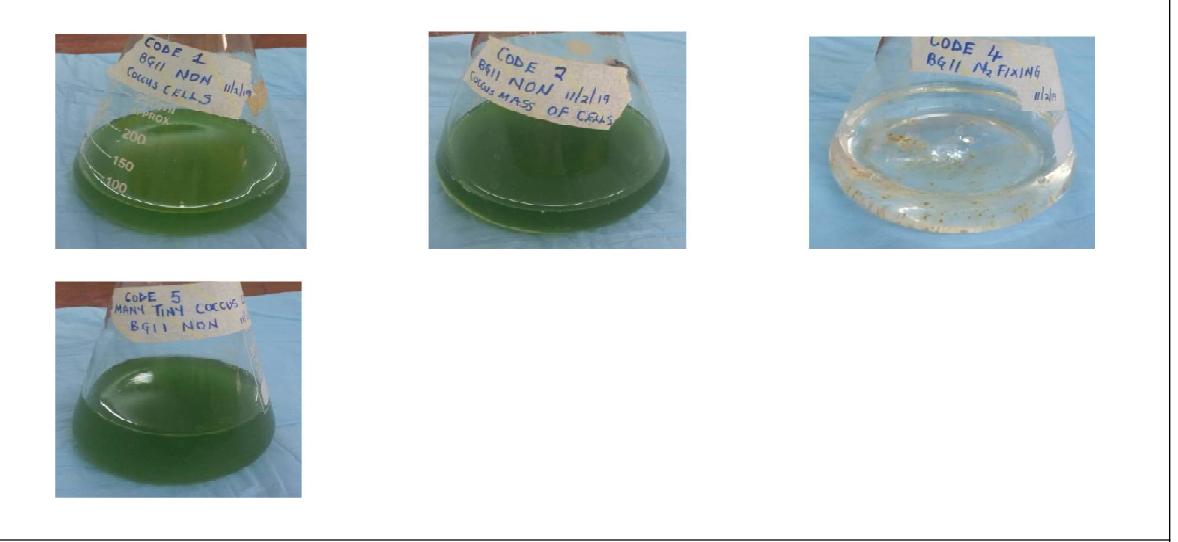
Figure 1: Axenic cyanobacterial cultures growing in liquid media (from left to right C1, C2, C4 and C5 respectively)